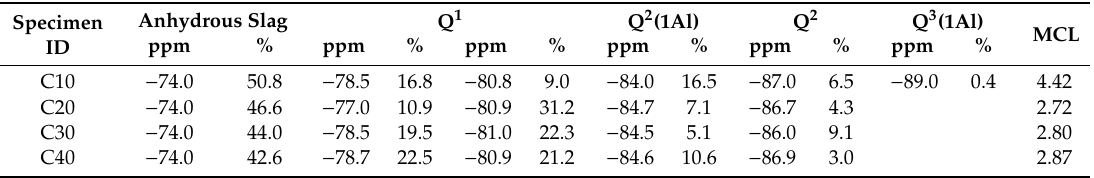
Figure 4. Normalized 29 Si MAS NMR spectra of raw slag and mixtures of slag and CCR. Table 2. Deconvolution results of 29 Si MAS NMR spectra of CCR-loaded slag. The estimated chi-square tolerance value is 10 − 6 . The provided data are the chemical shift (ppm) and integration of the relative area (%).